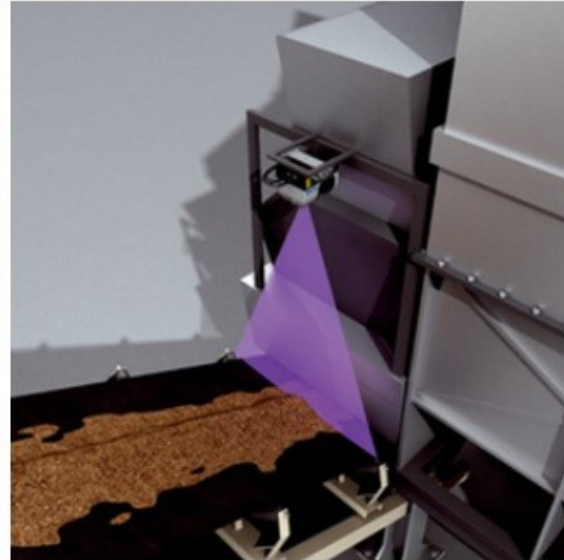
Figure 4: Optical flow crusher monitor and conveyor belt tracking